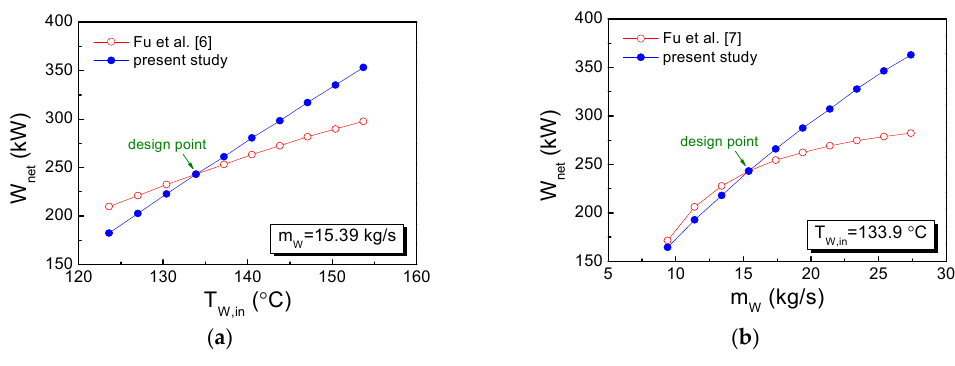
Figure 7. Net power output as functions of ( a ) T W,in and ( b ) m W .